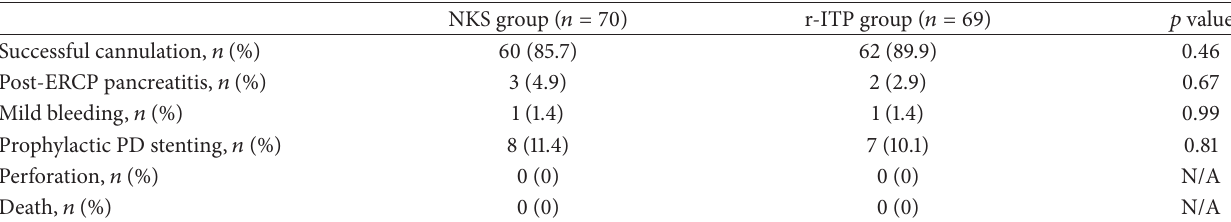
Table 2: Efficacy and safety of precut papillotomy